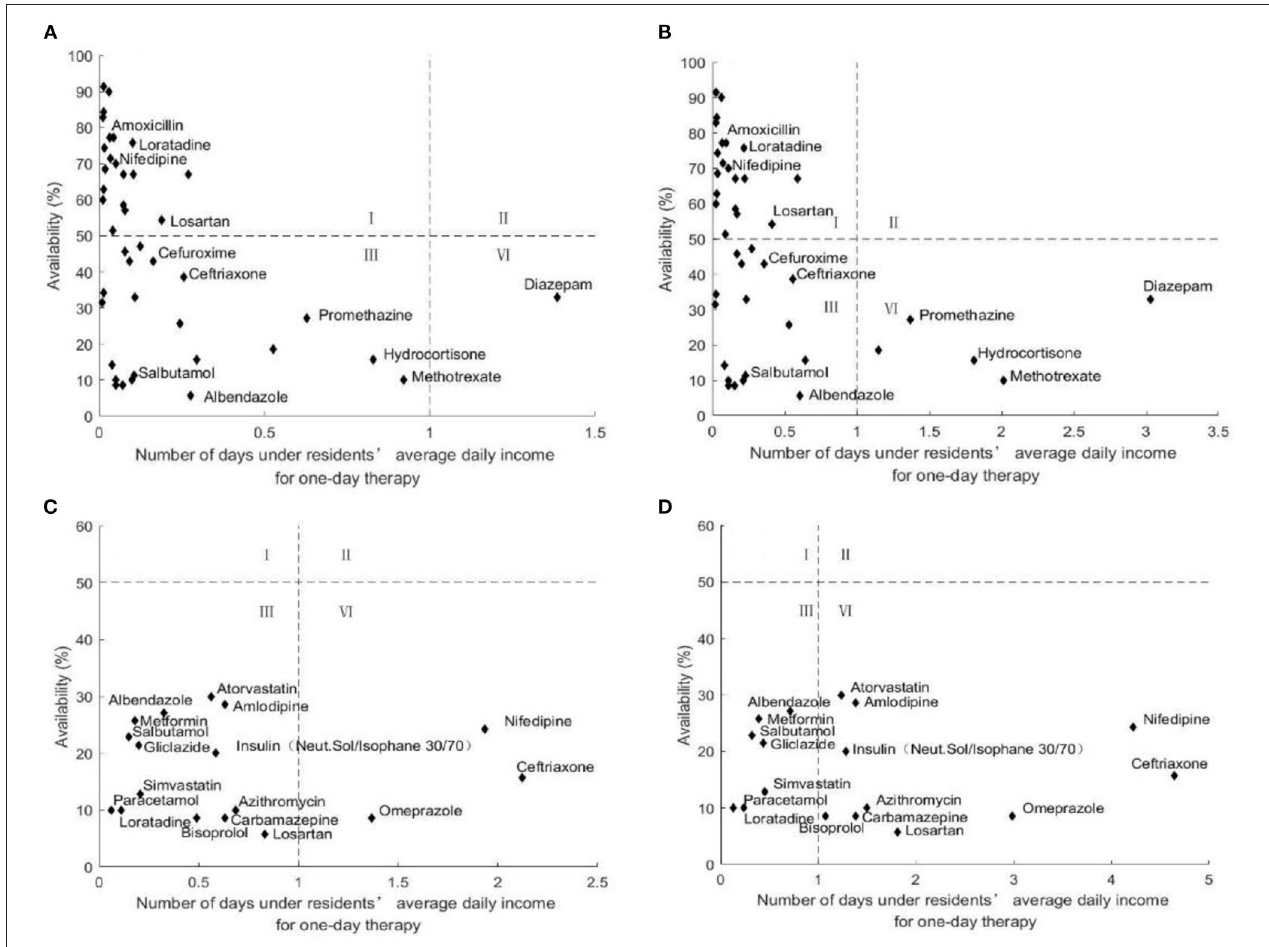
FIGURE 7 | Comprehensive analysis of medicine availability and affordability in seven cities of Jiangsu, in 2021. (A) Comprehensive analysis of LPGs availability and affordability for urban residents. (B) Comprehensive analysis of LPGs availability and affordability for rural residents. (C) Comprehensive analysis of OBs availability and affordability for urban residents. (D) Comprehensive analysis of OBs availability and affordability for rural